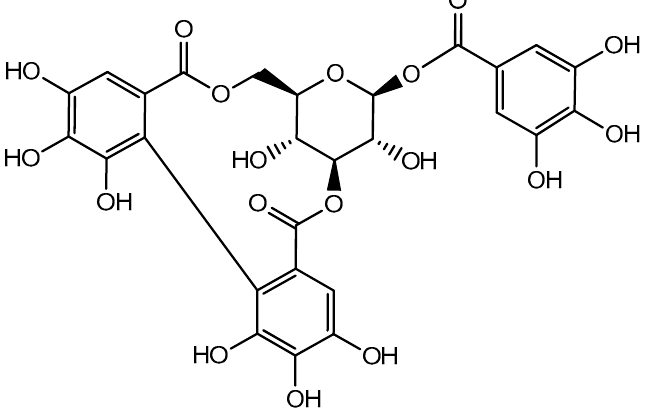
Figure 1. The chemical structure of corilagin.